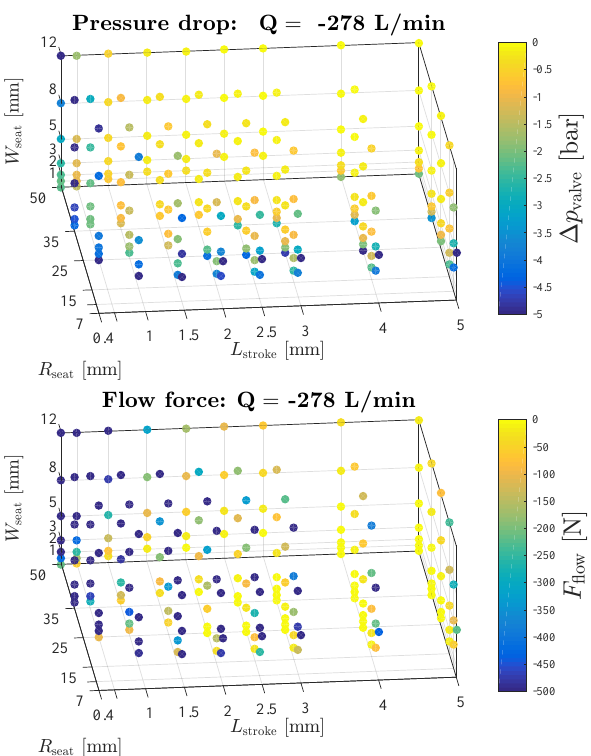
Figure 15: Numerical results throughout the design space for a flow rate of -278